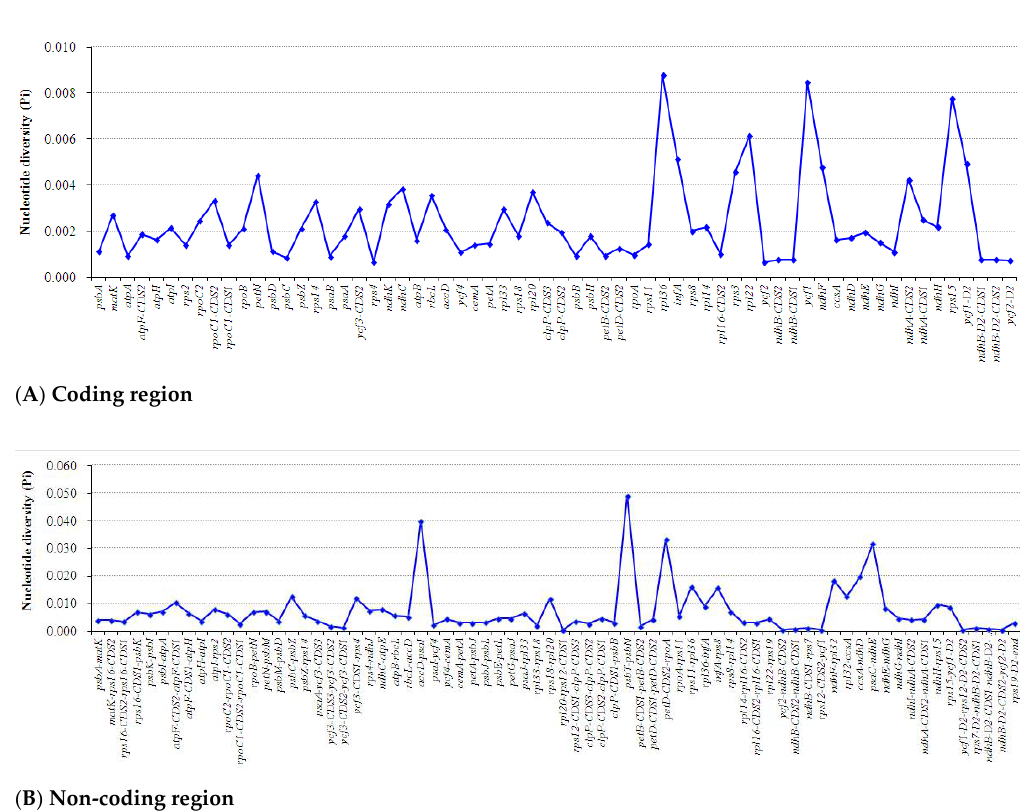
Figure 7. Sliding window analysis of the whole chloroplast genomes among five Alpinia accessions.Window length: 800 bp; step size: 200 bp. X-axis: position of the midpoint of a